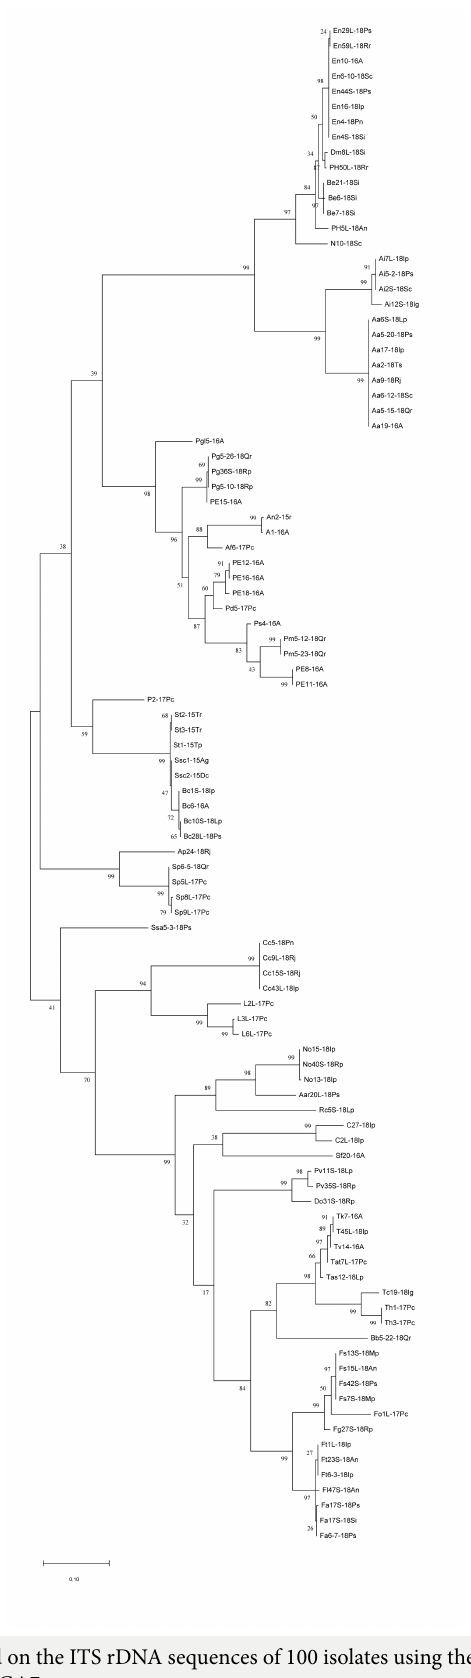
Figure 1 Dendrogram constructed based on the ITS rDNA sequences of 100 isolates using the maximum likelihood method based on the Kimura-two-parameter model in